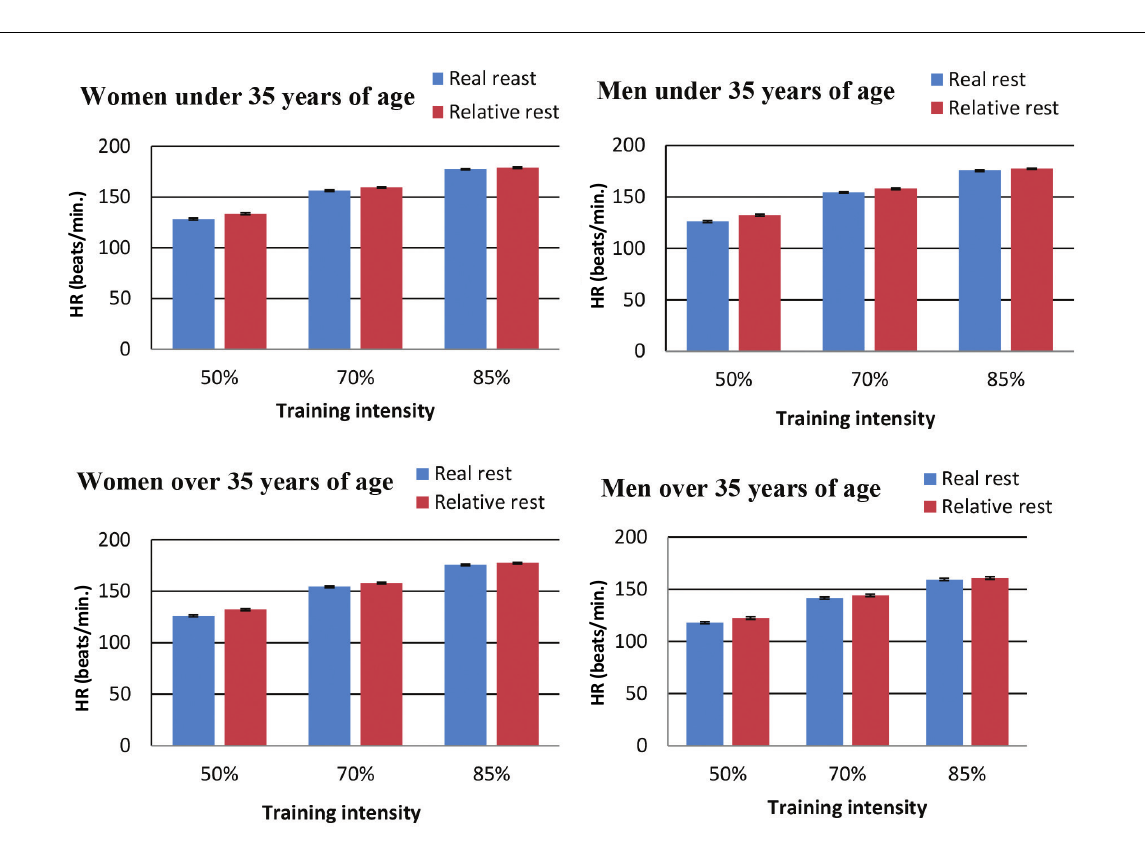
Figure 2. Values of HR calculated by taking into account real or relative rest